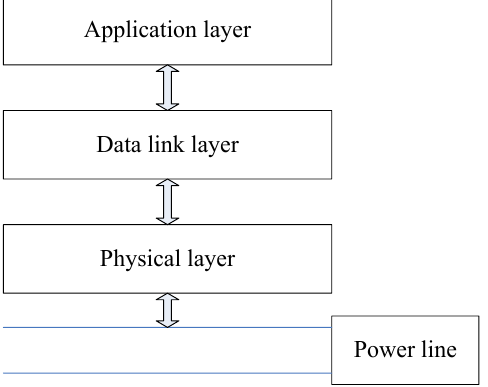
Figure 8. Communication network protocol stack definition.